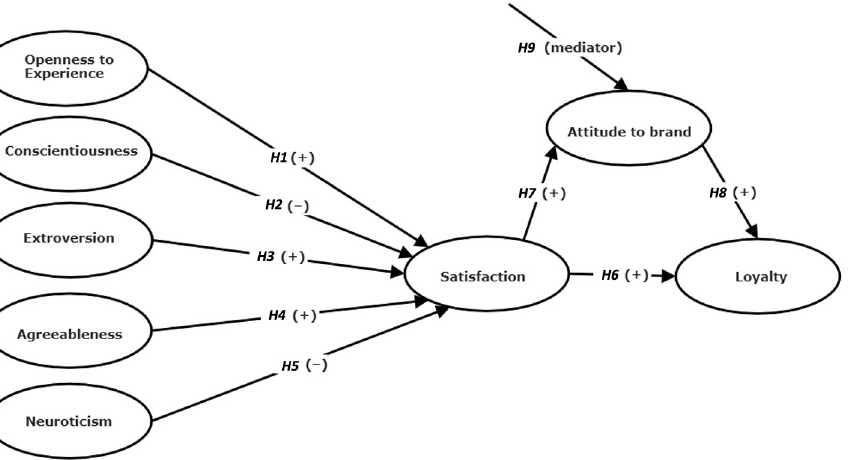
Figure 1. Research